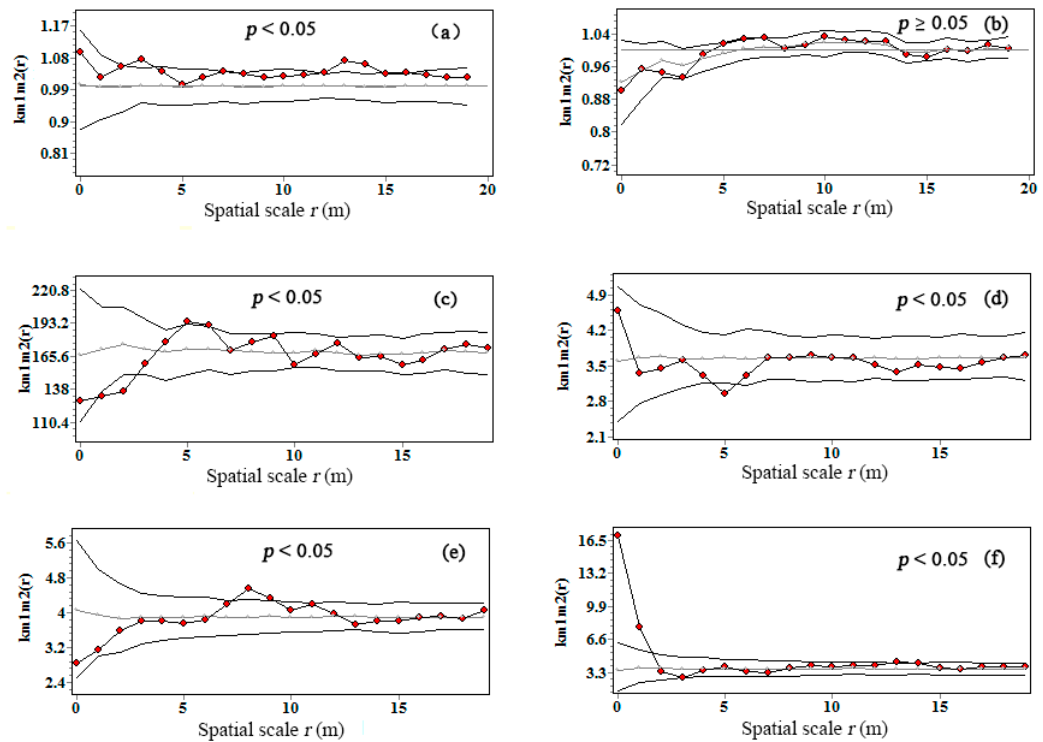
Figure 6. Bivariate mark correlation function k m1 m2 (r) for interspecific interaction on C accumulation in Pinshuo opencast coal mine, China. Gray line indicated the theoretical k mm (r) ; black line with red dots indicated the observed the k mm (r) ; black line without red dots indicated the 95% simulation envelops. ( a ) Planted R. pseudoacacia vs. seeded-in R. pseudoacacia ; ( b ) planted R. pseudoacacia vs. P. tabuliformis ; ( c ) planted R. pseudoacacia vs. U. pumila ; ( d ) seeded-in R. pseudoacacia vs. U. pumila ; ( e ) seeded-in R. pseudoacacia vs. P. tabuliformis ; ( f ) P. tabuliformis vs. U.